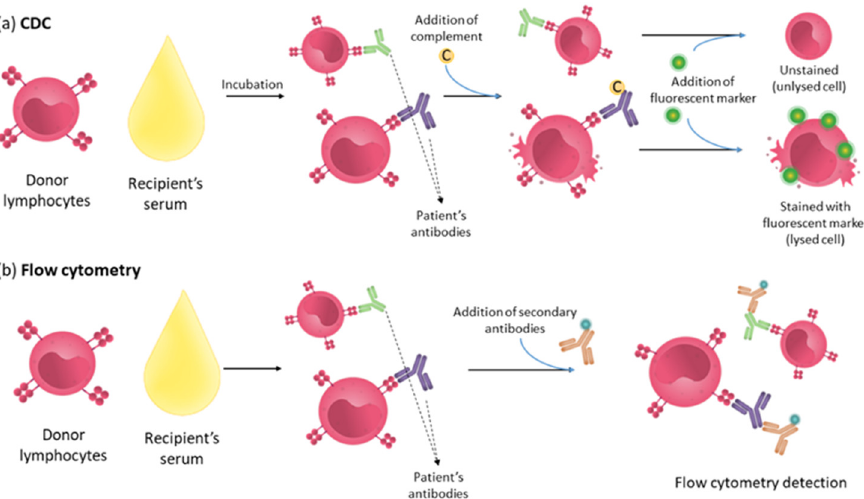
Figure 2. Assays detecting anti-HLA antibodies. ( a ) CDC: Recipient’s serum is incubated with donor’s lymphocytes; after this, the incubation complement is added, triggering cell lysis on cells bound to complement-binding antibodies. Detection is made using a fluorescent marker that stains lysed cells. ( b ) Flow cytometry: Recipient’s serum is incubated with donor’s lymphocytes. In this assay, after this incubation, secondary antibodies fluorescently labelled are added to samples to detect cells with the patient’s antibodies bound.